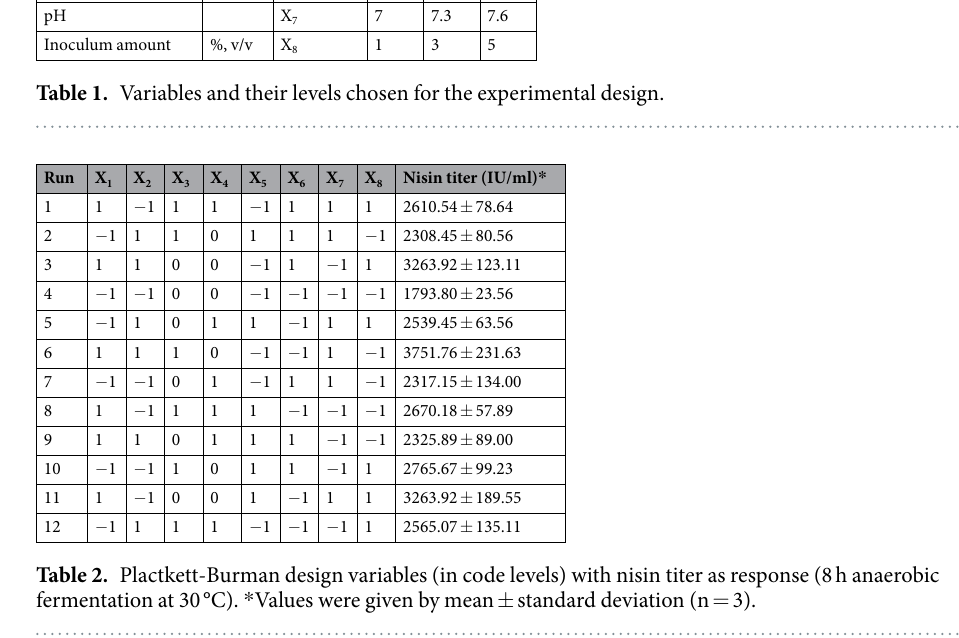
Similar DH value in response to enzyme loading and enzymatic time had been reported by Kong et al . 29 . When S:L was 1:20, it was shown that enzyme loading of 10000 U/g and 12000 U/g gave almost same DH value for 6 h which was higher than that with enzyme loading of 8000 U/g. Using 10000 U/g enzyme loading, the DH value increased marginally with increase of hydrolysis time to 8 h and then decreased obviously at 10 h. The highest DH value of 12.24% could be attained with enzyme loading of 10000 U/g for 8 h and S:L 1:20. Statistical optimization of DSM medium compositions and fermentation conditions for nisin production.